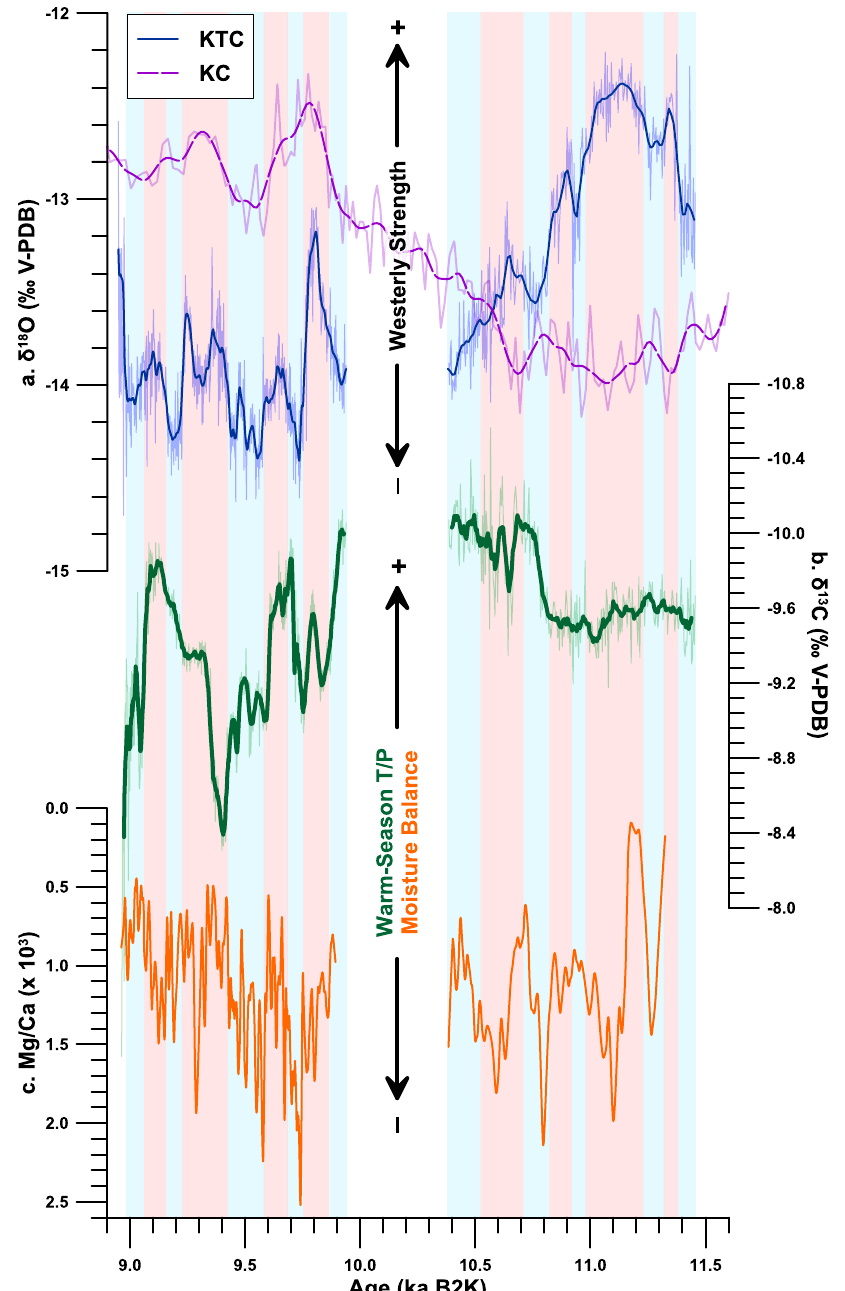
Fig. 3 Multiproxy interpretation of Early Holocene circulation and regional climate. a Speleothem δ 18 O data from KTC (solid blue) and KC (dashed purple). b KTC δ 13 C. c KTC Mg/Ca. Bold lines represent a 15-point LOESS smoothing of each dataset. Red and blue shading are de fi ned by positive and negative δ 18 O anomalies, respectively, in